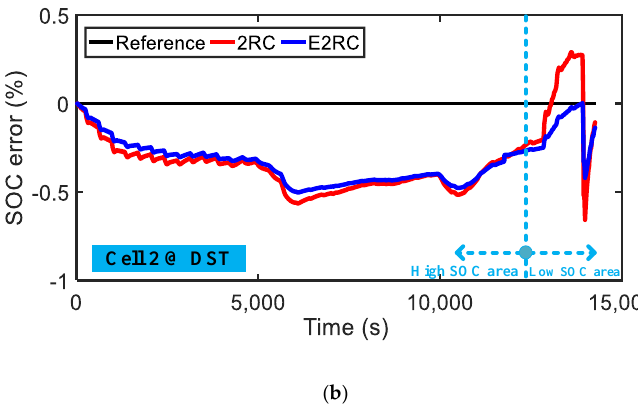
Figure 8. SOC estimation results under DST working condition. ( a ) SOC estimated value; ( b ) SOC error.